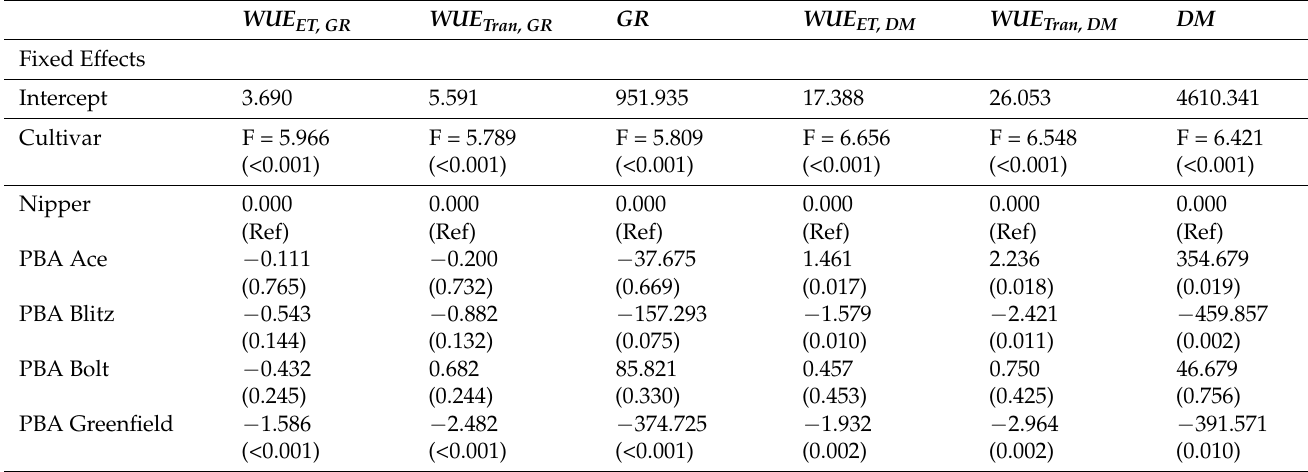
Table 4. Estimates and F-ratios of fixed factors, variances of random factors, and conditional R 2 of mixed models for each variable. Values in parentheses indicate p -values. Ref = the reference level for that factor against which the other levels of that factor are